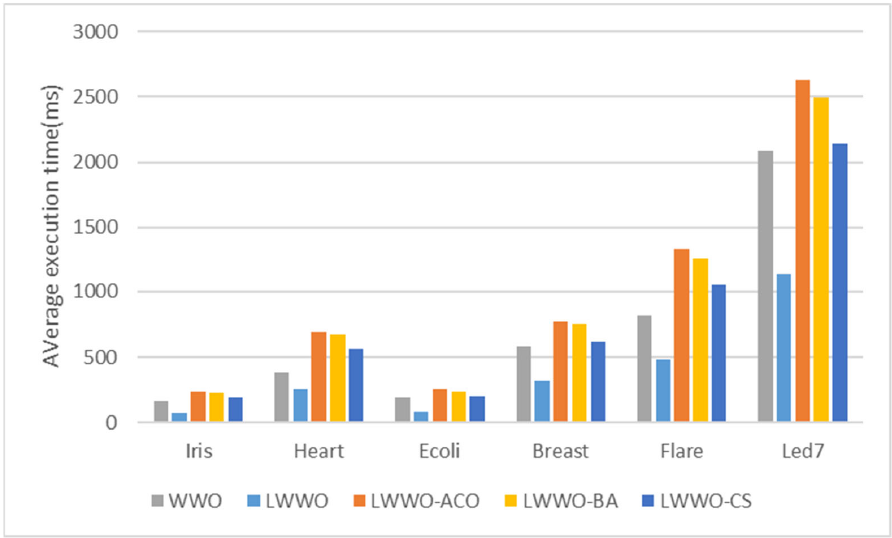
Figure 5. Comparison of the execution time of each algorithm.